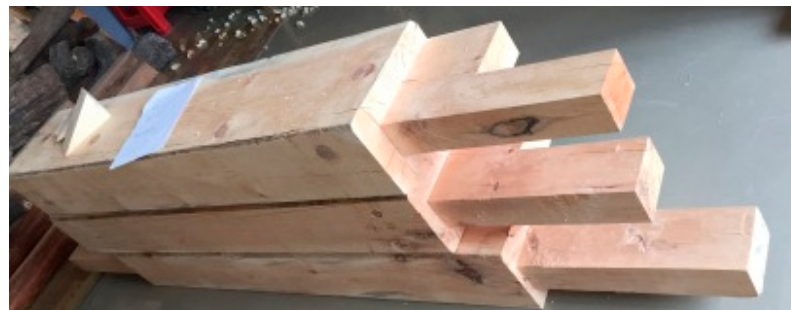
Figure 12. Loose joint.